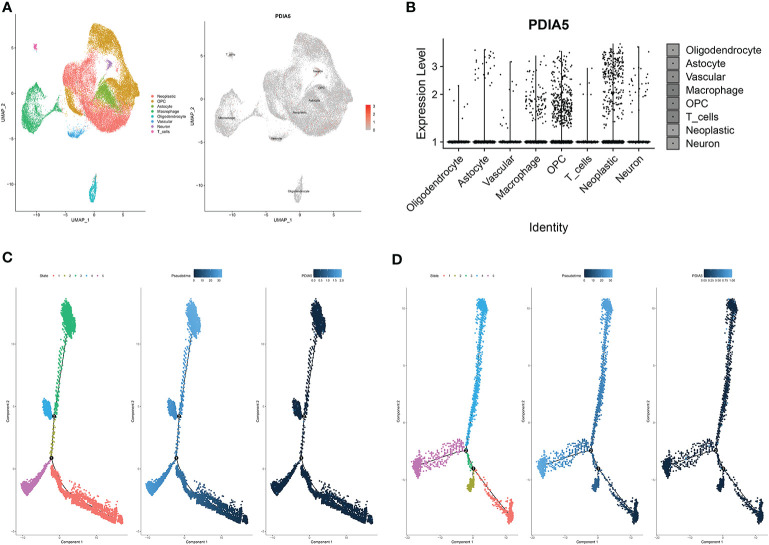
scRNA-seq results for PDIA5 in gliomas. (A) The cells were categorized into eight clusters (left). Scatter plots of PDIA5 expression distribution of different cell clusters (right). Gray areas represent the whole cell clusters. The red dots represent cell with PDIA5 expression. (B) Violin plot of PDIA5 expression distribution of different cell clusters. (C) The single-cell trajectory of neoplastic cells contains four main branches. Cells are colored based on state (left), pseudotime (middle), and PDIA5 (right). (D) The single-cell trajectory of macrophages contained four main branches. Cells are colored based on state (left), pseudotime (middle), and PDIA5 (right).